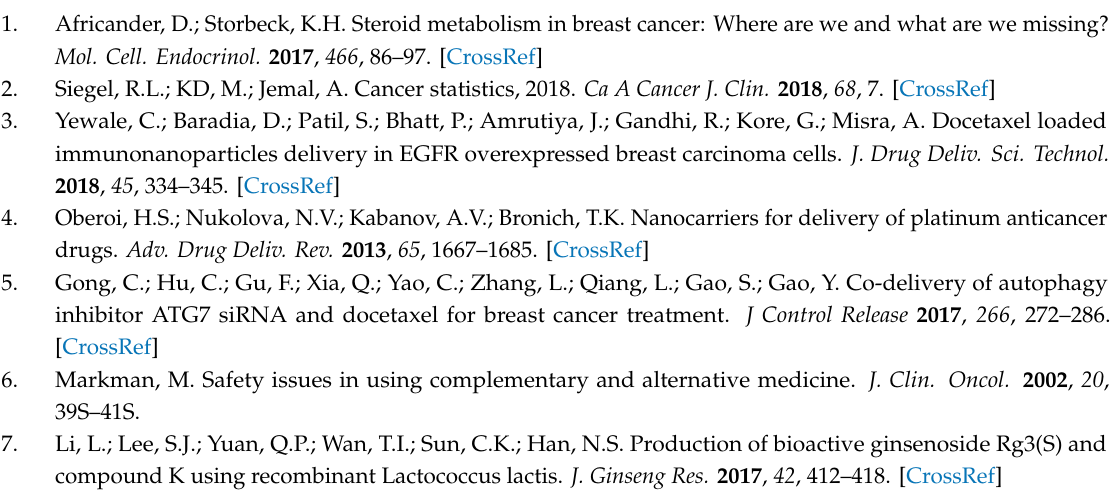
Table S1: ADMET property evaluation, Figure S1: Thin layer chromatography (TLC) analysis of time-course transformation of ginsenoside Rb1 by β -glucosidase. S is the mixture of ginsenoside standards, Figure S2: Thin layer chromatography (TLC) analysis of time-course transformation of ginsenoside Rg3 at 121 ◦ C with high pressure processing. S is the mixture of ginsenoside